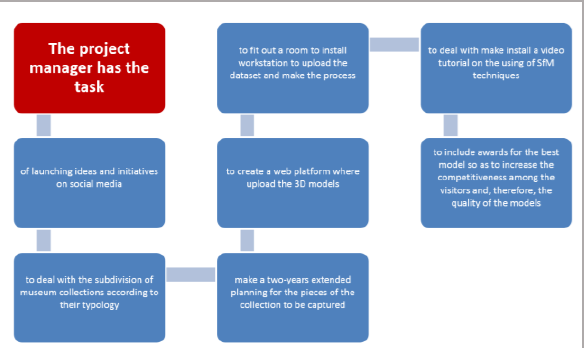
Figure 19. The big sculptures category